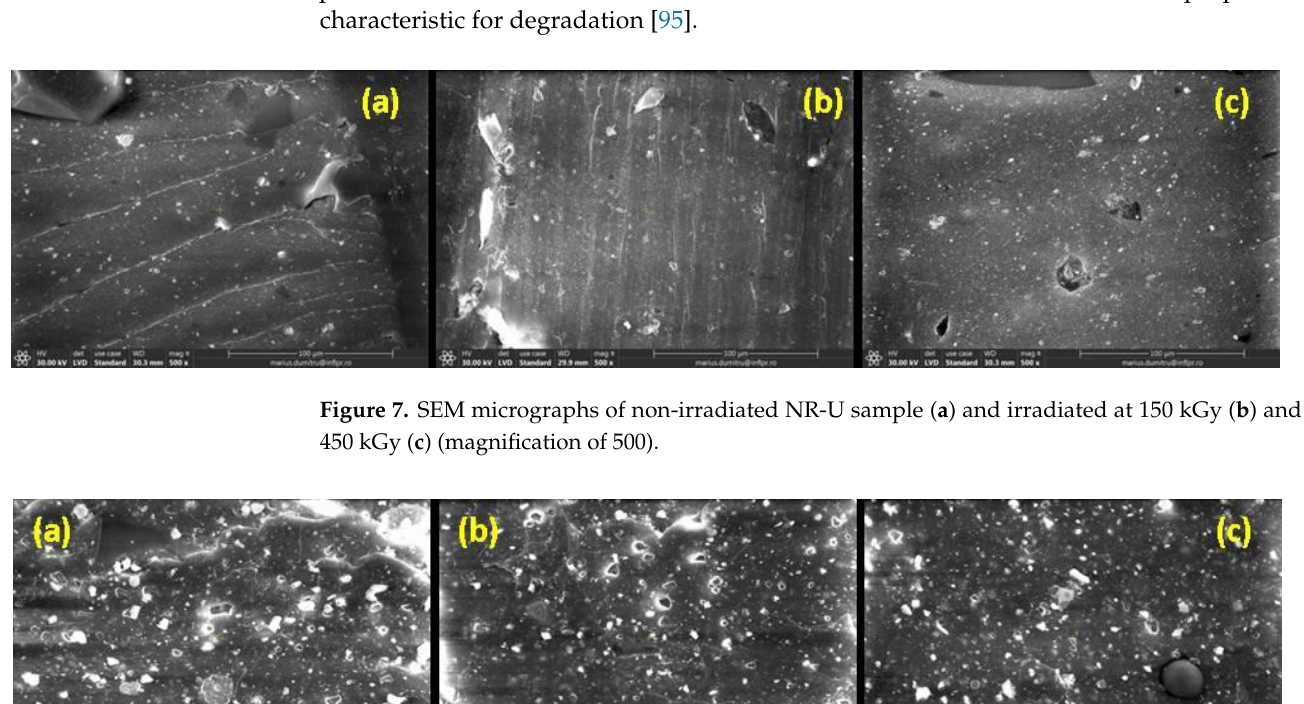
Figure 6. SEM micrographs at of non-irradiated control sample — natural rubber ( a ) and irradiated at 150 kGy ( b ) and 450 kGy ( c ) (magnification of 500).